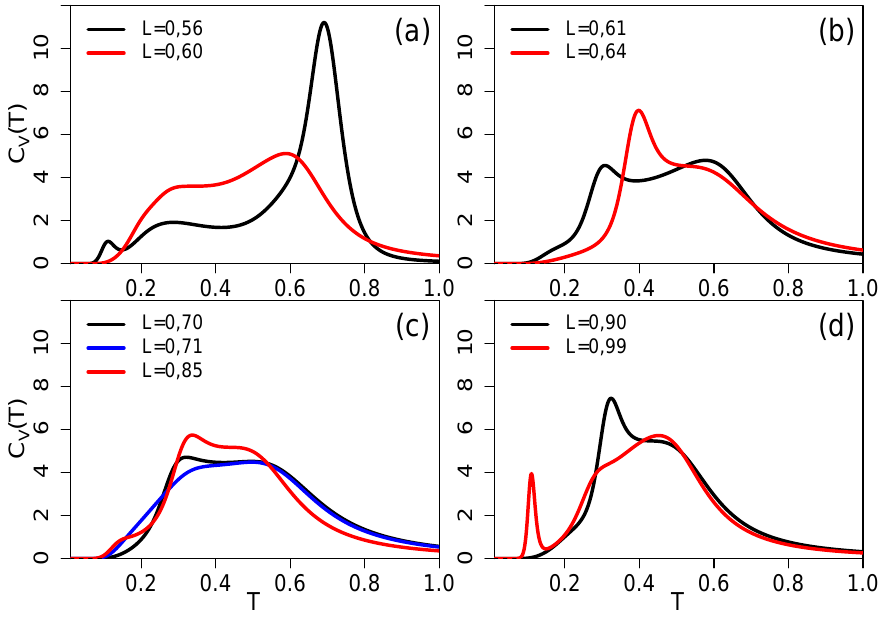
Figure 4. Canonical specific heat as a function of temperature for the bond length range of semi-flexible chains. ( a – d ) show different parts of this